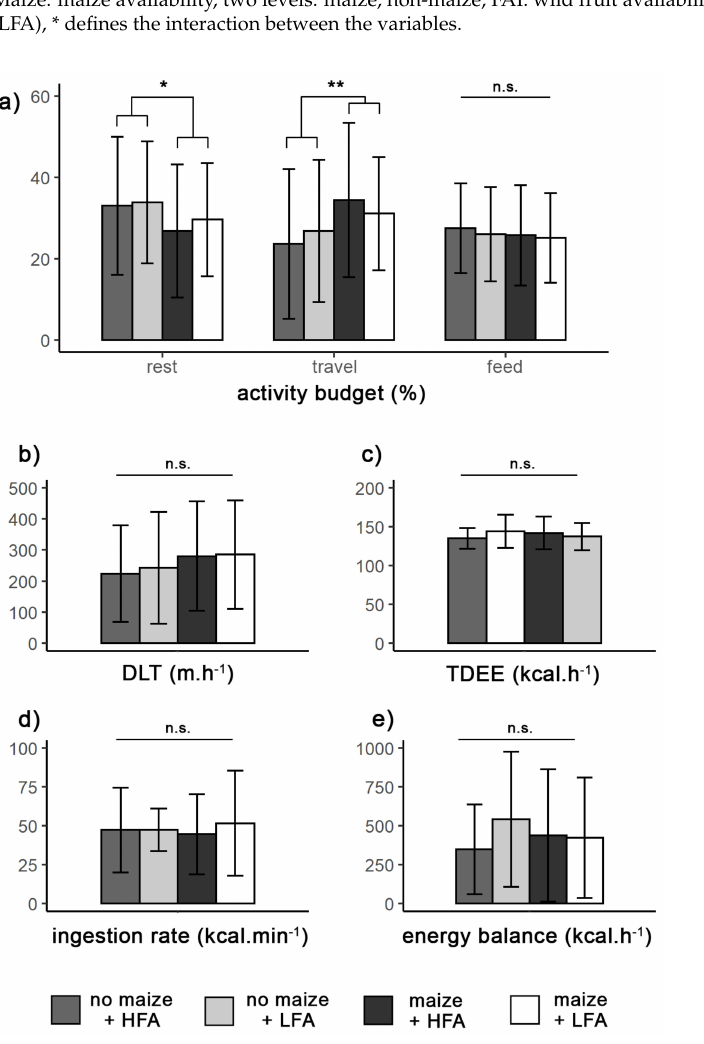
Figure 3. Budget of the main activities ( a ), daily paths (DLT) ( b ), energy expenditures (TDEE) ( c ), ingestion rate ( d ), and energy balance ( e ) of the Sebitoli community according to maize and wild fruit availability between January 2016 and January 2019. LFA: low wild fruit availability; HFA: high wild fruit availability; * p < 0.05; ** p < 0.005; n.s.: not significant. Bars represent standard